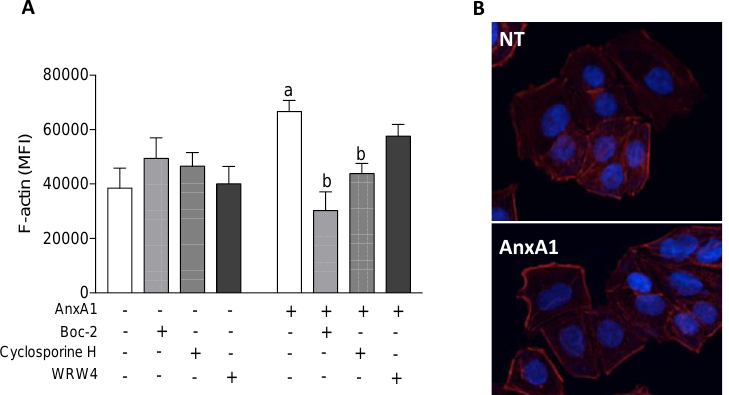
Figure 5. AnxA1 induced F-actin polymerization via FPR1. F-actin was quantified on uterine epithelial cells 2 h after incubations, using phalloidin-rhodamine by confocal microscopy. ( − ) means absence and ( + ) means presence of treatments ( A ). Representative images of F-actin polymerization are shown ( B ). The data are expressed as mean ± standard error of mean of three to five independent experiments. a p < 0.05 vs. NT; b p < 0.05 vs.